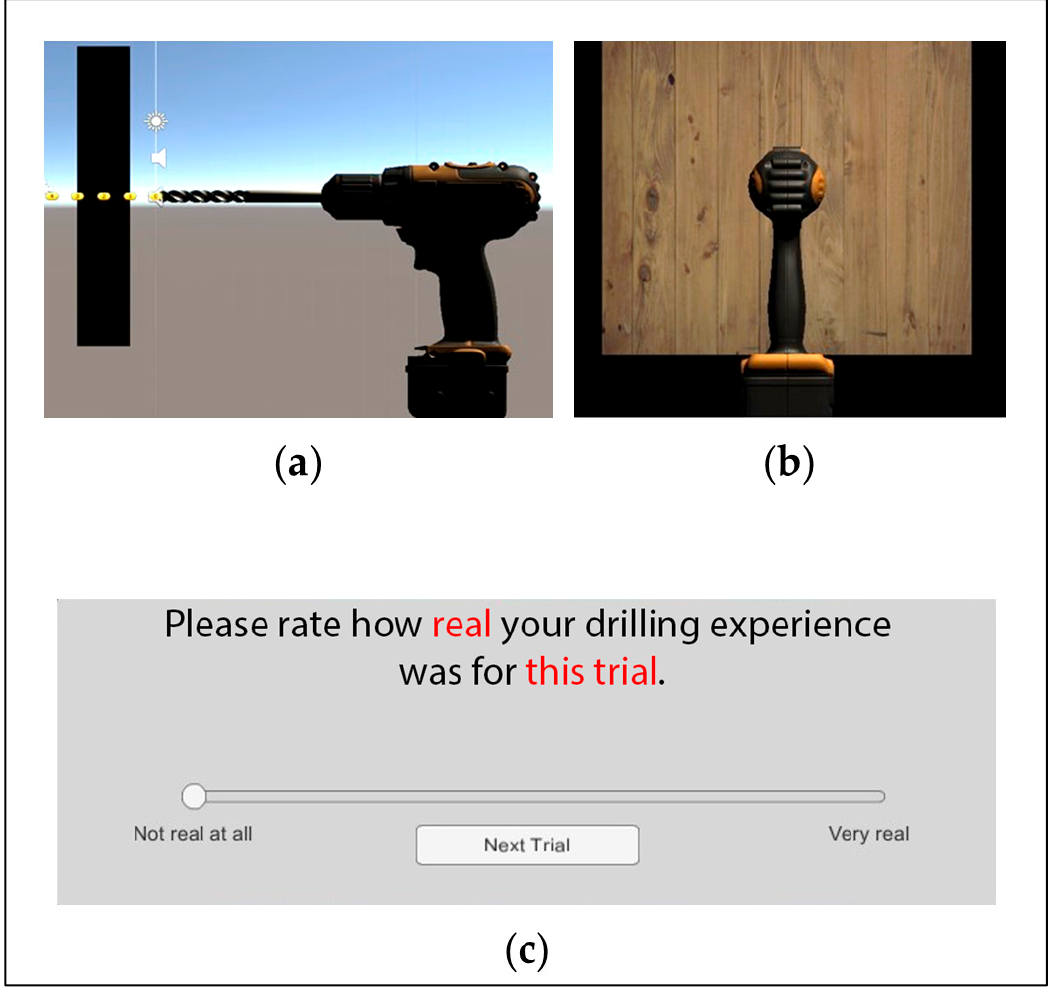
Figure 2. Scenes in the drilling simulation. ( a ) Side view visible only during familiarization trials. ( b ) Front view shown throughout experimental trials. ( c ) Subjective rating scale presented after each trial.